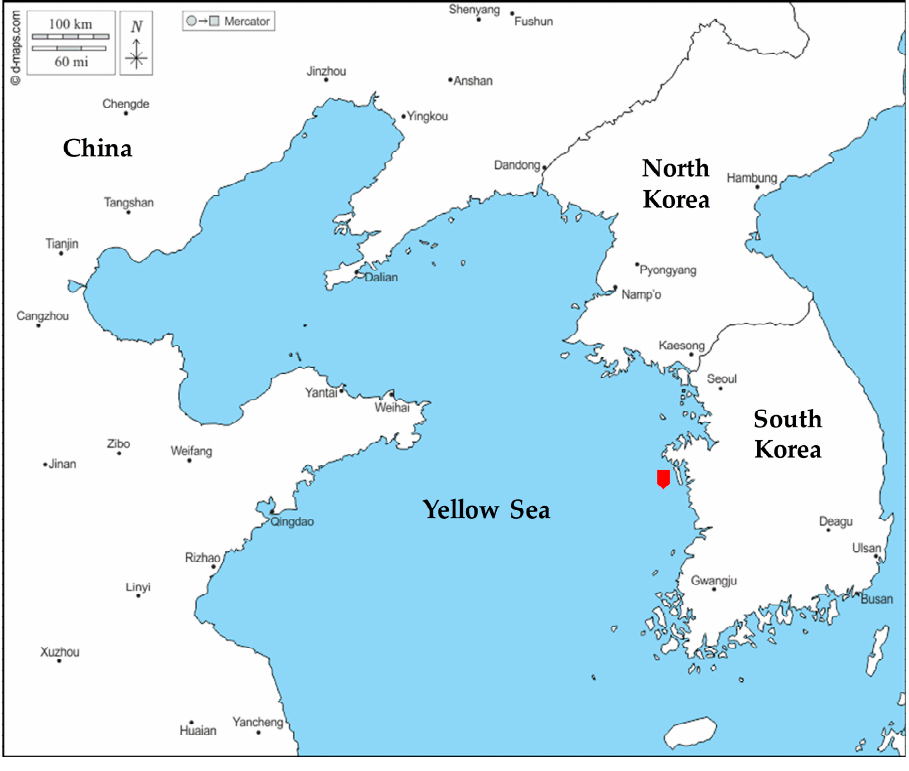
Figure 1. Map showing the sampling location (Red spot). Map was downloaded from d-map (https://d-maps.com/carte.php?num_car=6021&lang=en, accessed on 10 January 2022).